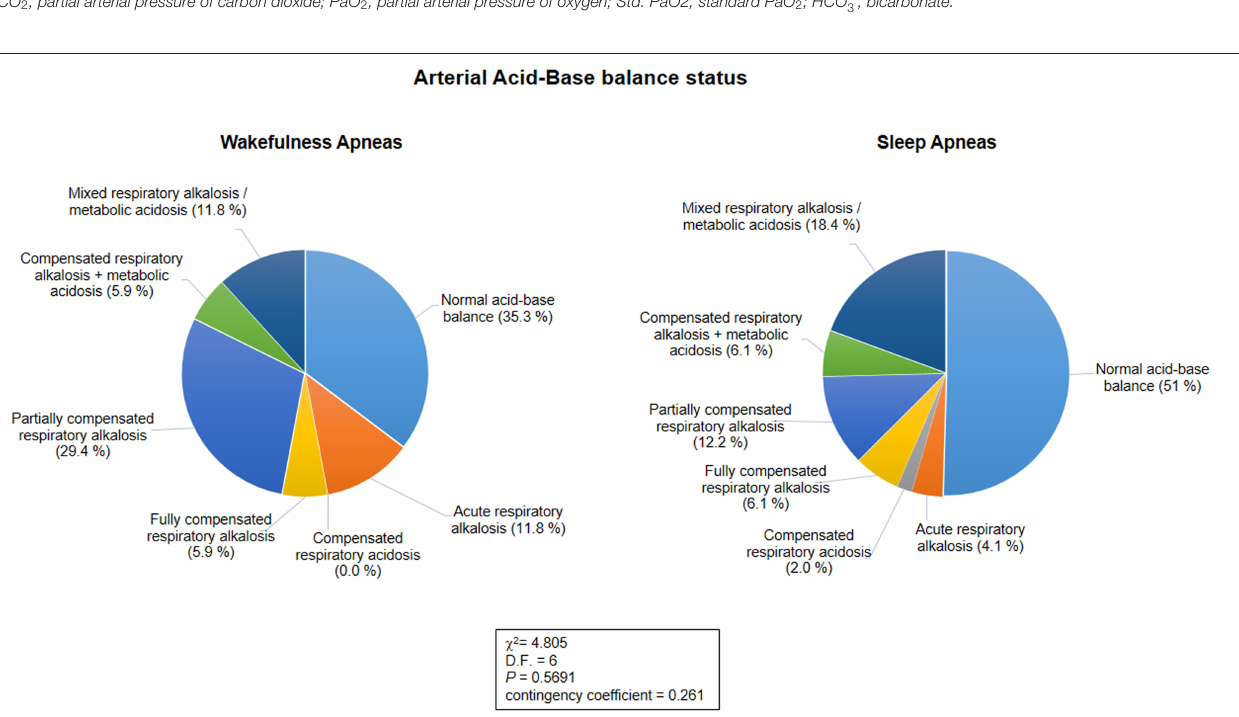
Seizure frequency in the SA epi + subgroup was as